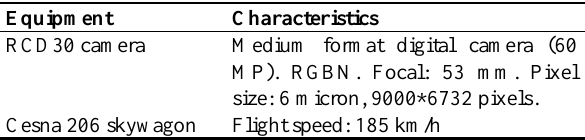
Table 1. Description aerial surveying equipment